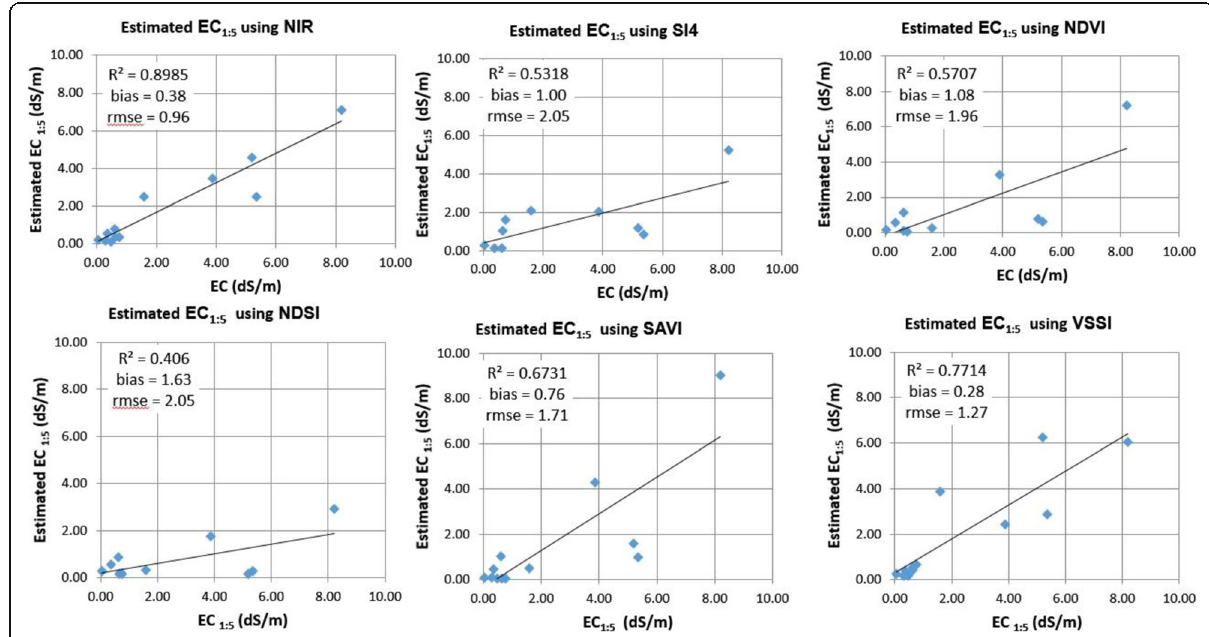
Fig. 9 Correlation of EC 1:5 derived from Landsat 8 OLI and observed EC 1:5 from field survey data for the 12 test samples over Tra Vinh